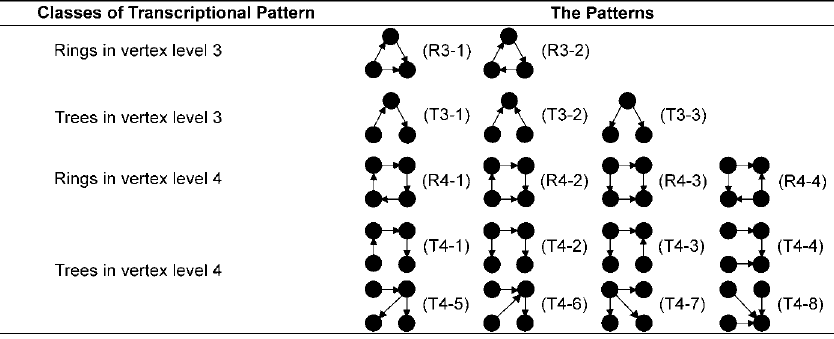
Figure 1. The Basic Subgraphs at the 3- and 4-Vertex Level The IDs of each subgraph are given in brackets. DOI: 10.1371/journal.pcbi.0020047.g001 PLoS Computational Biology |